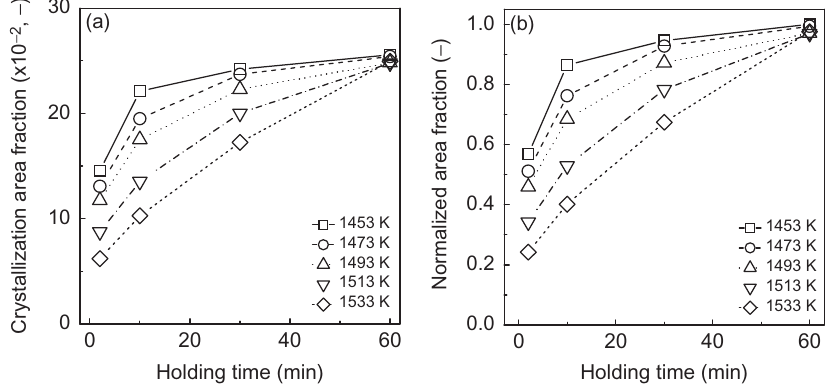
Figure 4: Influence of holding time on crystallization area fraction (a) and normalized area fraction (b) of phosphate-enriched phase in CaO – SiO 2 – FeO – Fe 2 O 3 – P 2 O 5 steelmaking slags over a temperature range from 1453 to 1533 K,